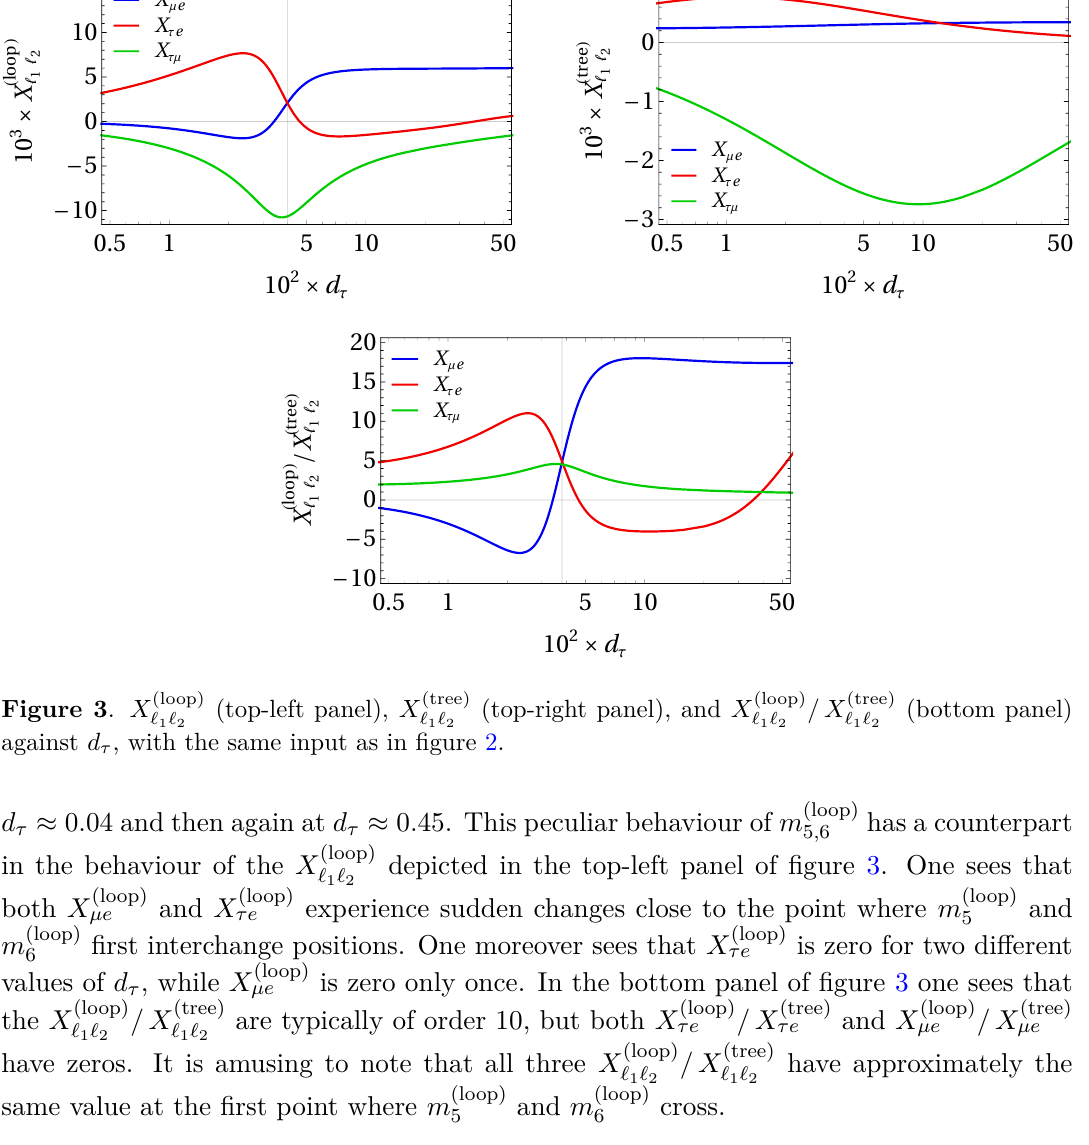
/ X (tree) (bottom panel) ‘ 1 ‘ 2 ‘ 1 ‘ 2